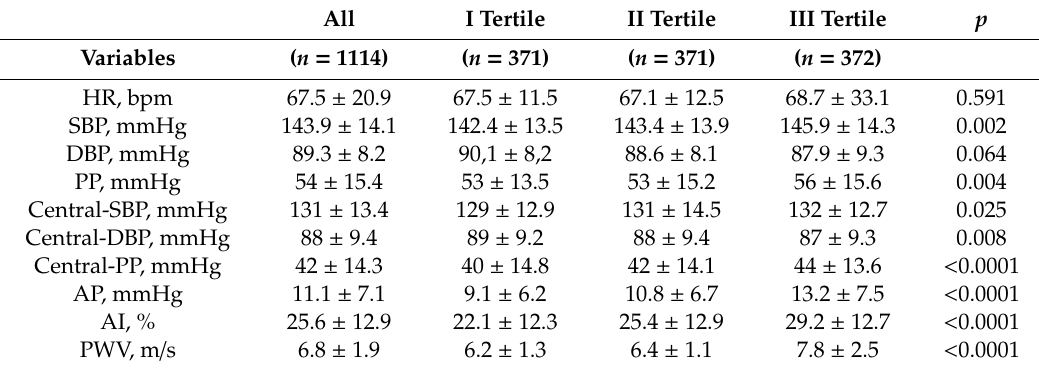
Table 2. Peripheral and central hemodynamic parameters of the study population, according to increasing tertiles of serum UA. All I Tertile II Tertile III Tertile